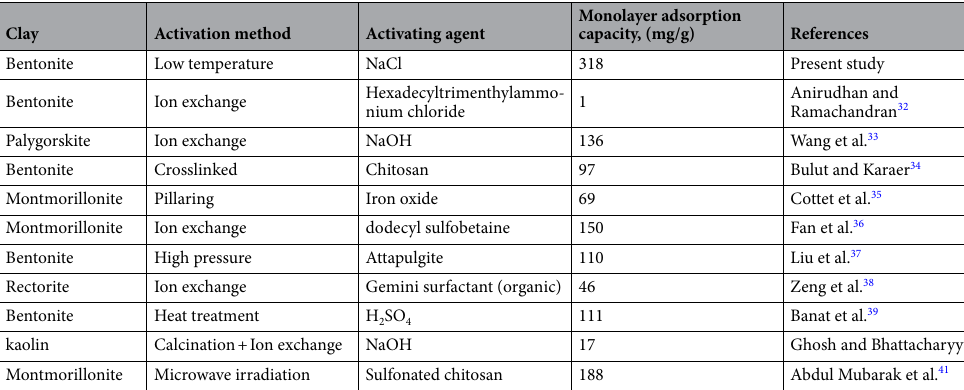
Table 2. Comparative evaluation of monolayer adsorption capacities for MB onto different clay